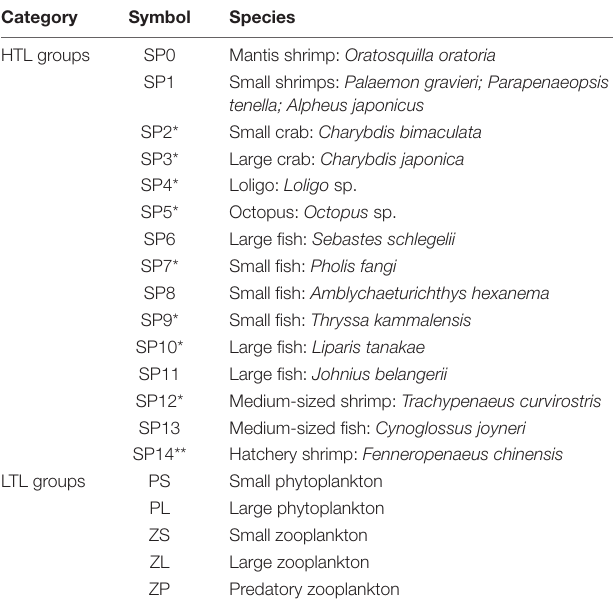
over the cells within a two-dimensional gridded map of the study area, which consists of 1,435 square grids (0.01 ◦ × 0.01 ◦ ). The parameter “Random walk range” controls the range of